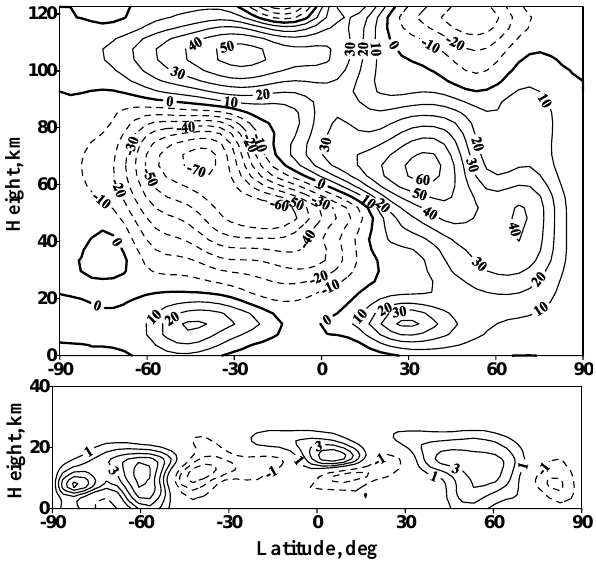
Fig. 6. Latitude-height sections of the zonal mean flow calculated for January 1960 (upper panel) and estimated zonal flow changes in the troposphere during 40 years (lower panel).